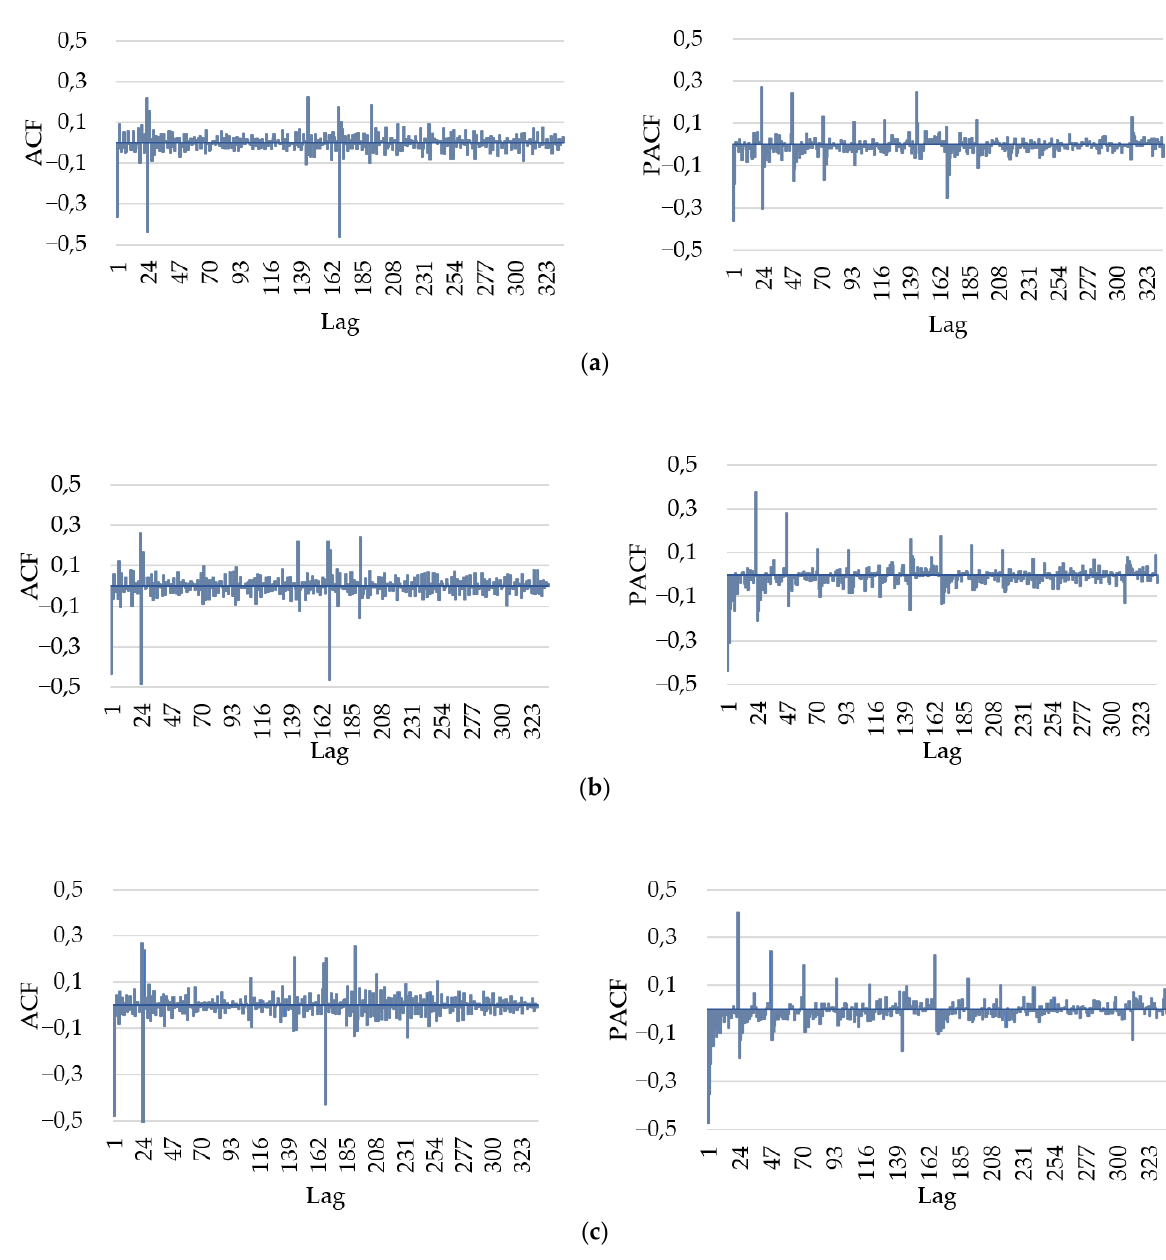
Figure 9. ACF and PACF of differentiated noise-disturbed time series: ( a ) NSR = 30%, ( b ) NSR = 100%, ( c ) NSR = 200%.